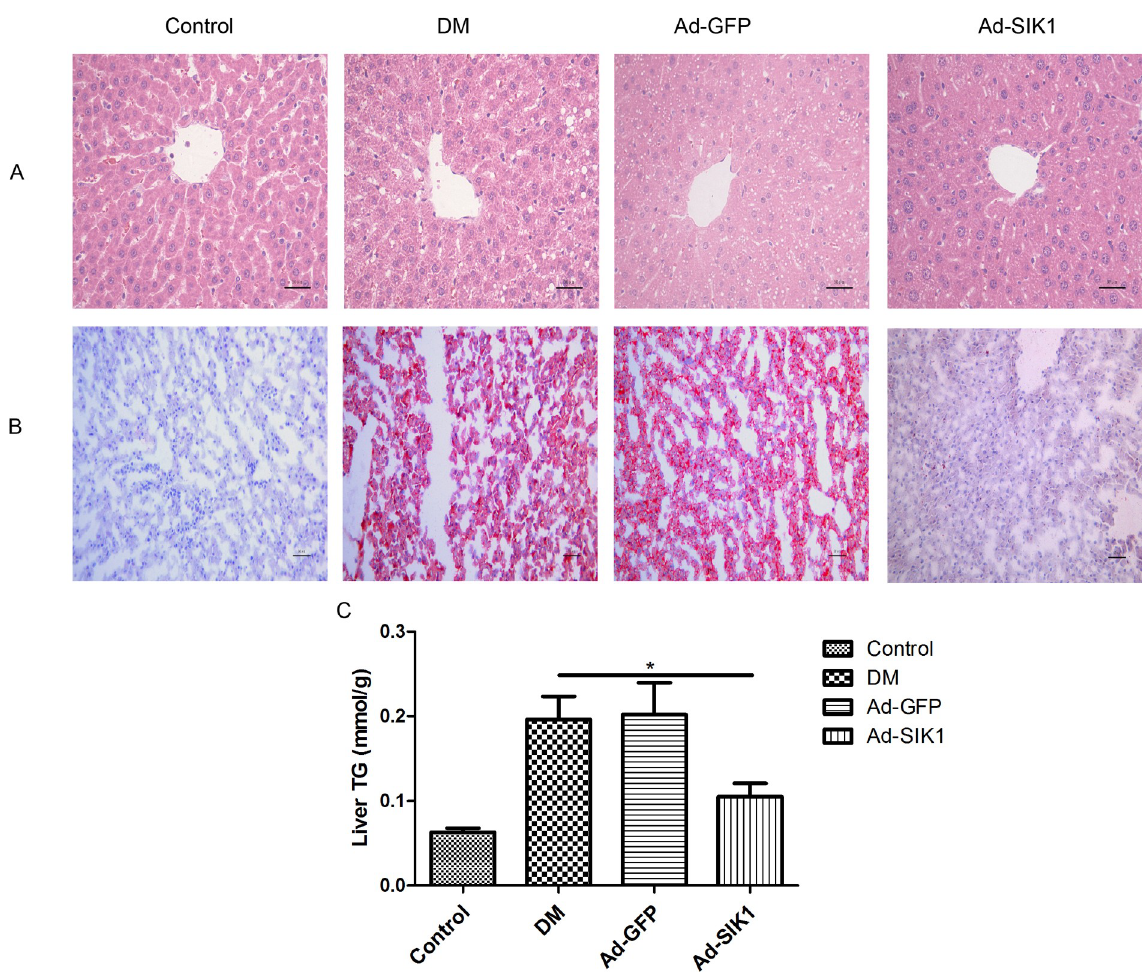
Fig 2. Effects on histology and TG of liver of HFD/STZ-induced diabetic rats. (A) Liver tissue sections were stained with HE ( × 200); (B) oil red O to observe liver lipid content; (C) Hepatic TG content. Scale bar is 50 μ m. Control, non-diabetic control rats fed a normal diet; DM, untreated HFD/STZ-induced diabetic rats; Ad-GFP, HFD/STZ-induced diabetic rats treated with Ad-GFP; Ad-SIK1, HFD/STZ-induced diabetic rats treated with Ad-SIK1.